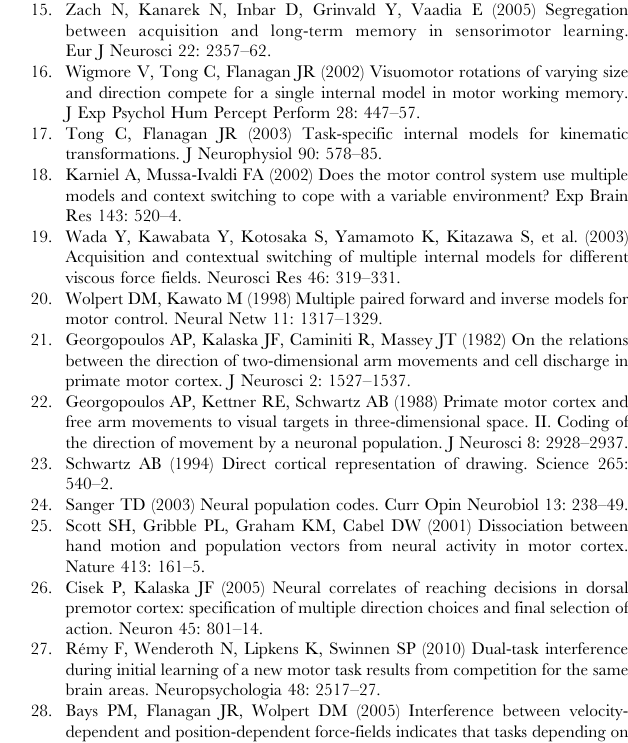
Figure S3 Surface map for recording locations of cells representing the rotation or arbitrary association tasks (during the TO epoch), taken from monkey M, extracted from MRI analysis (Biospec Bruker, 4.7 T) and verified by skull endocast analysis. Abbreviations: as, arcuate sulcus; cs, central sulcus; ps, principal sulcus. Black dots: location of cells with increased SNR to directions used during rotation (n= 21). Gray dots: locations of cells with increased SNR to colors used during arbitrary association (n =20). Red dots: location of cells with increased SNR both for colors used during arbitrary association and directions used during rotation (n =25). (TIF) Figure S4 Directional representation is unaltered by any of the learning sessions. (a) Discrimination ratio for the different movement directions before and after learning. Notation as Figure 2a–b. (b) PD distributions before (black) and after (red) learning. Note that none of the learning sessions altered directional representation, in general.